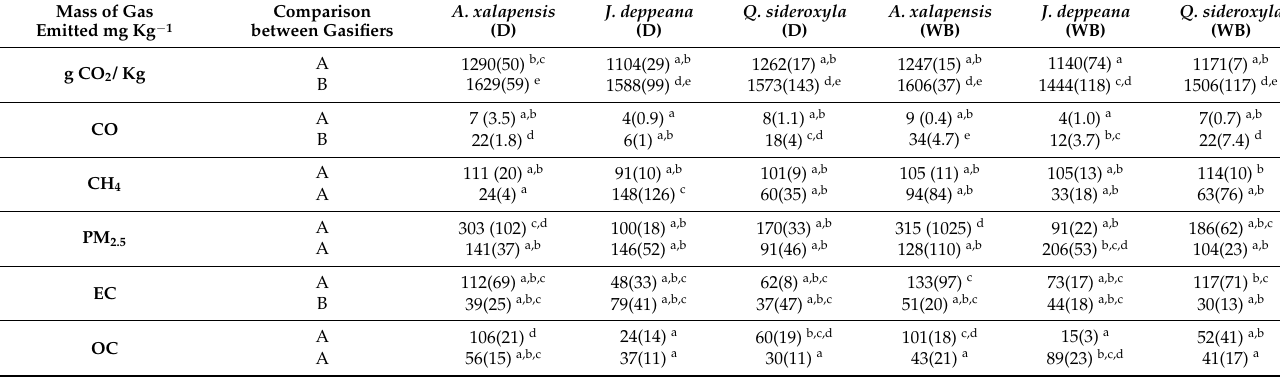
Standard deviation in parentheses. The letters in the direction of the columns ( a , b , c , d and e ) indicate statistical equality between species ( p ≤ 0.05), and the letters in the direction of the rows (A, B) indicate statistical equality between gasifiers ( p ≤ 0.05). D = without bark, WB = with bark. Rows in gray = T-LUD, rows in white =